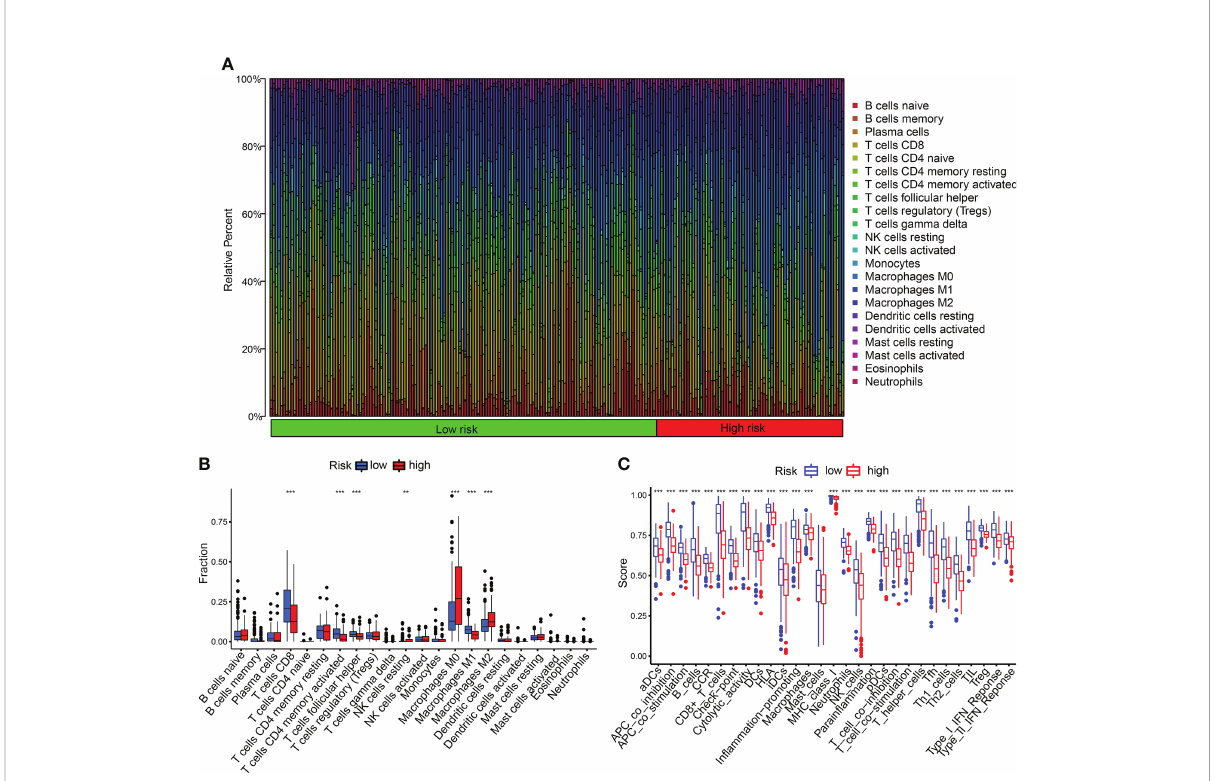
FIGURE 5 Immune characteristics in high- and low-CDIGPM groups. (A, B) The proportions of TME cells in high- and low-CDIGPM groups. (C) The molecular and immune-related function in high- and low-CDIGPM groups. (**p < 0.01, ***p < 0.001). CDIGPM: CD8 + T cells-associated immune genes prognostic